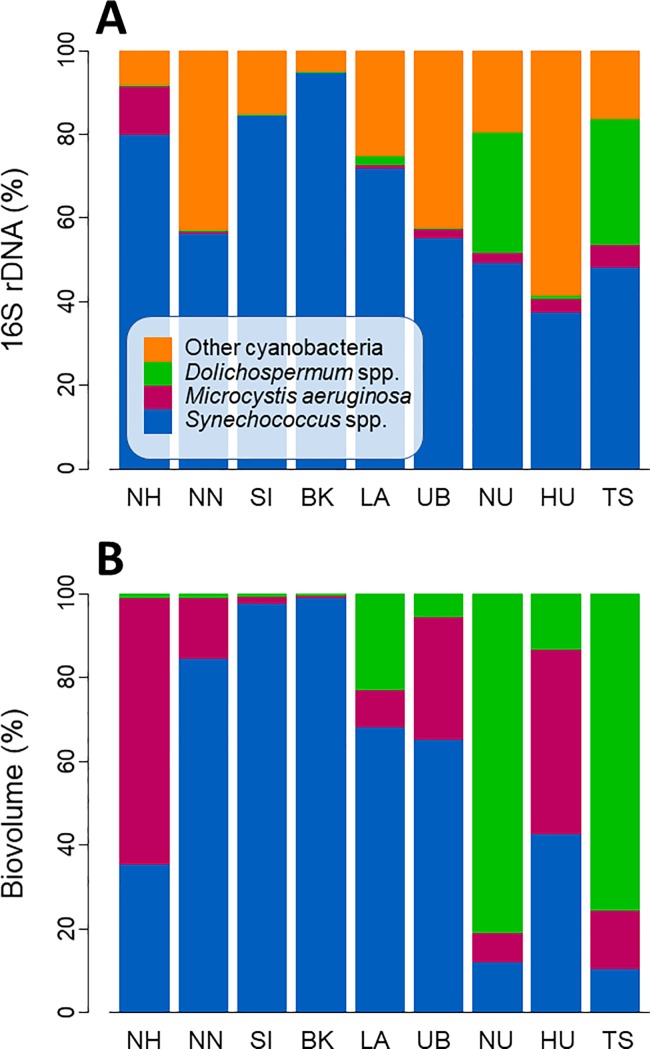
Cyanobacterial composition.Percent composition by (A) rDNA copy numbers for Synechococcus spp., Microcystis aeruginosa, Dolichospermum spp., and other cyanobacteria, and (B) biovolume for the three identified algal taxa. Water bodies are listed from left to right in order of increasing chl a concentration (Table 3).